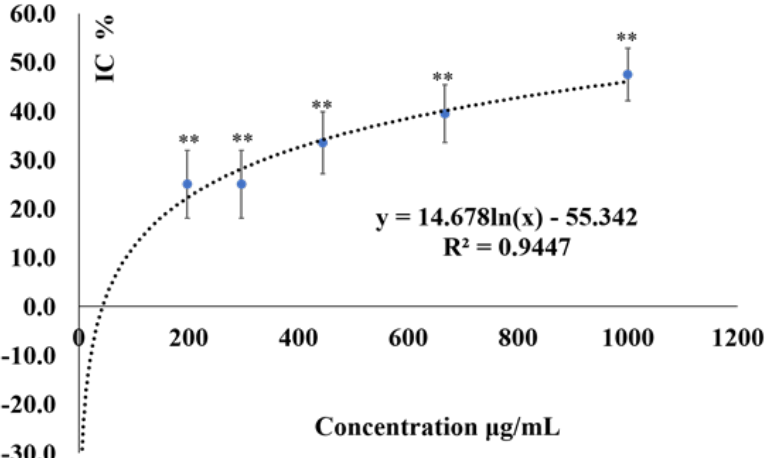
Figure 1: METH exerts dose-dependent inhibition of the proliferation of U-118 MG cells. The concentrations of METH were 198, 296, 444, 667 and 1000 μg/mL, and a CCK-8 test was used to evaluate the cell proliferation. Data are presented as means ± SD (n = 6), and the annotation ** indicates a p value < 0.01 versus control group.